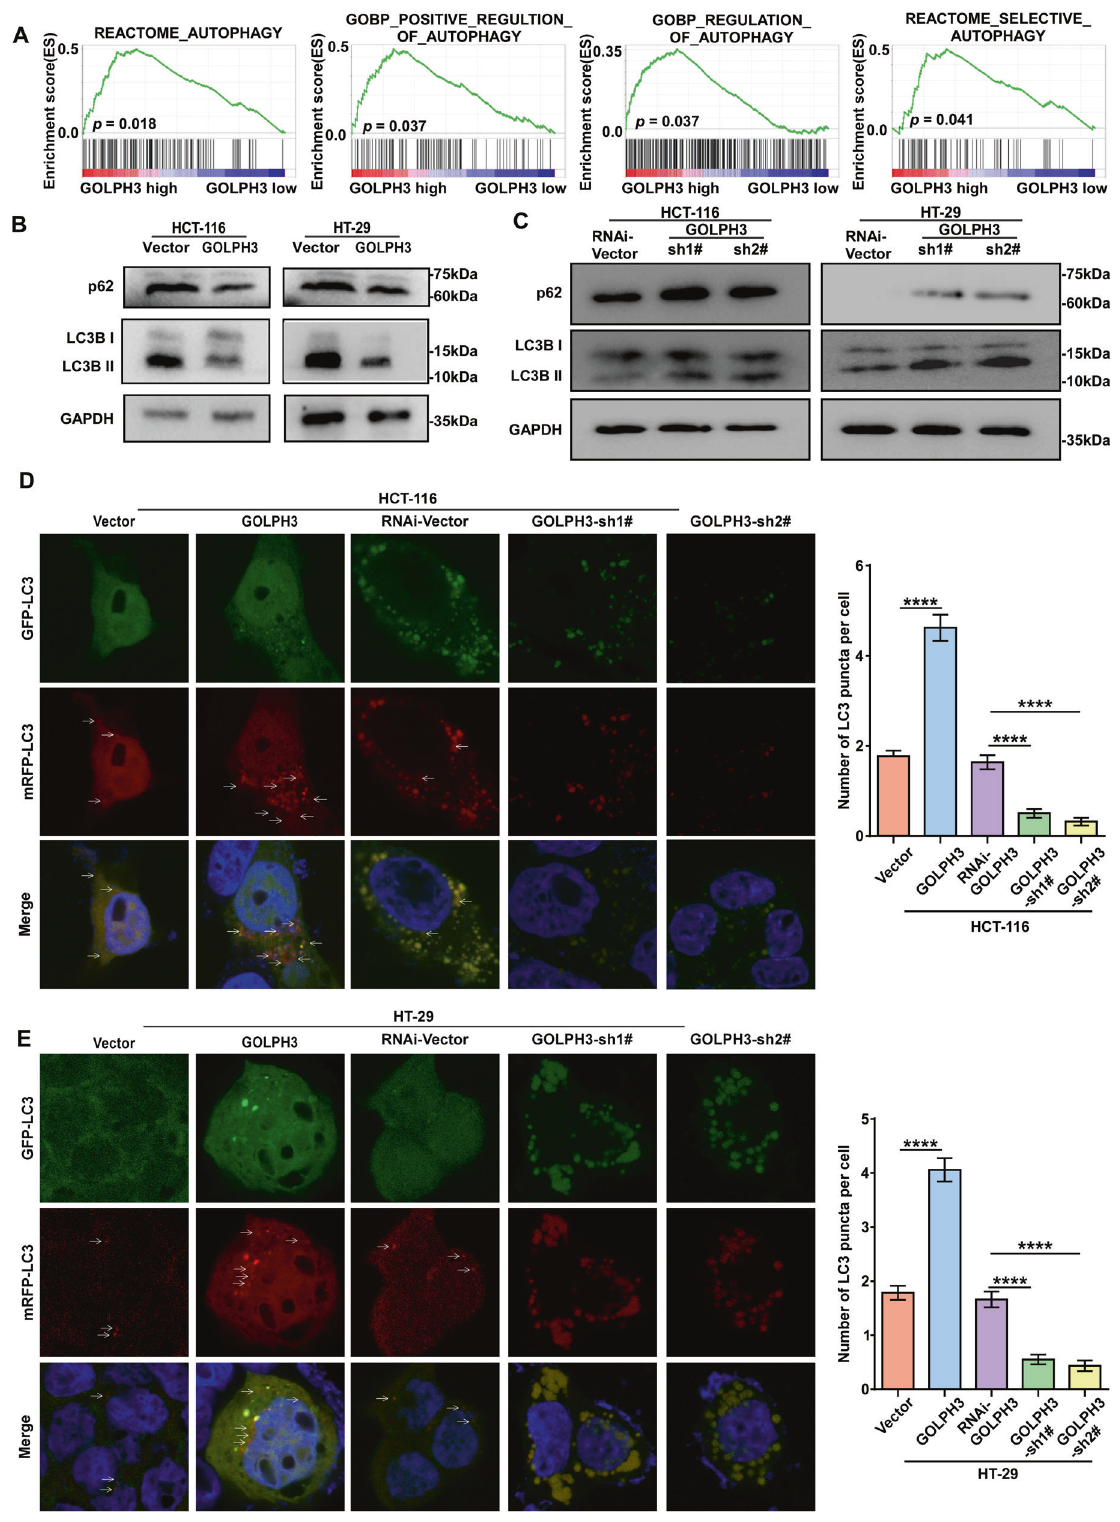
Fig. 5 GOLPH3 overexpression increases autophagy in colon cancer. A GSEA analysis of the correlation between RNA-seq-detected GOLPH3 gene expression and cell autophagy genes. B Western blotting analysis of autophagy markers in GOLPH3 -overexpressing cells and their controls; GAPDH was used as an internal reference. The levels of autophagy inhibition markers (p62 and LC3 II) decreased in GOLPH3 - overexpressing cells. C p62 and LC3 II accumulated when GOLPH3 was silenced. D Fluorescence microscopy observation of HCT-116 cells transfected with mRFP-GFP-LC3 plasmid. E A similar phenomenon to that seen in D was observed in HT-29 cells.